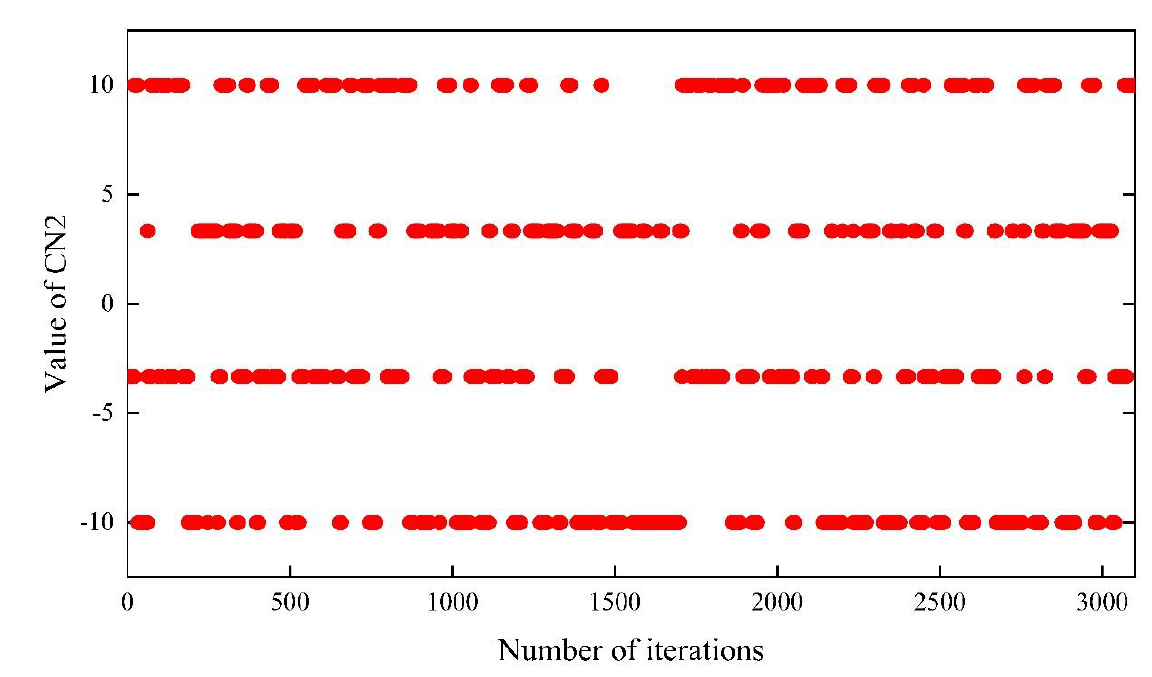
Figure 3. Schematic diagram of parameter sampling of Morris-at-a-time (MOAT) sampling method, taking CN2 as an example.